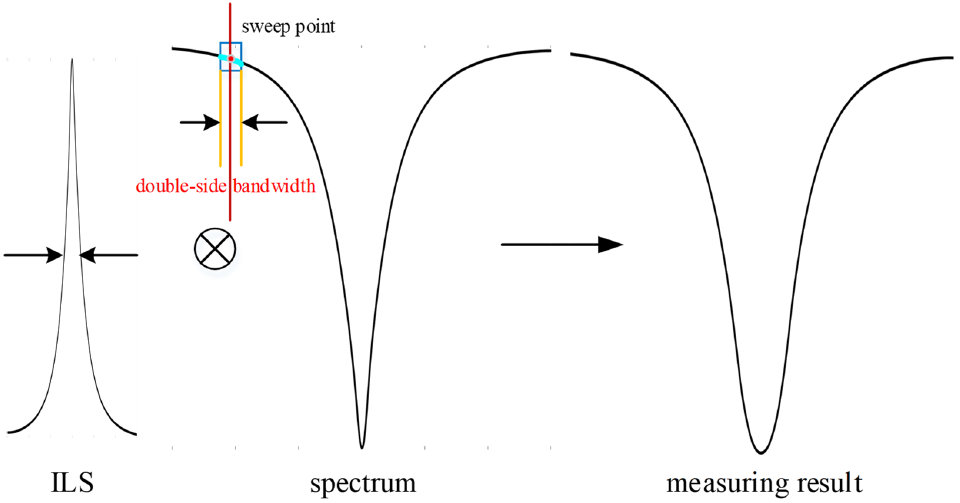
Figure 3. Schematic diagram of the measurement process.